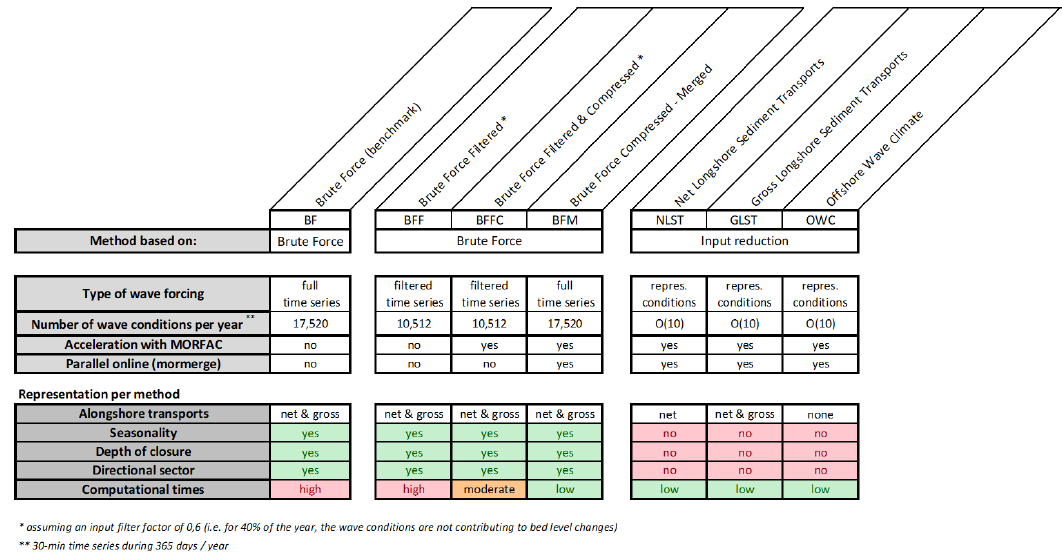
Figure 3. Characteristics of the considered morphodynamic acceleration